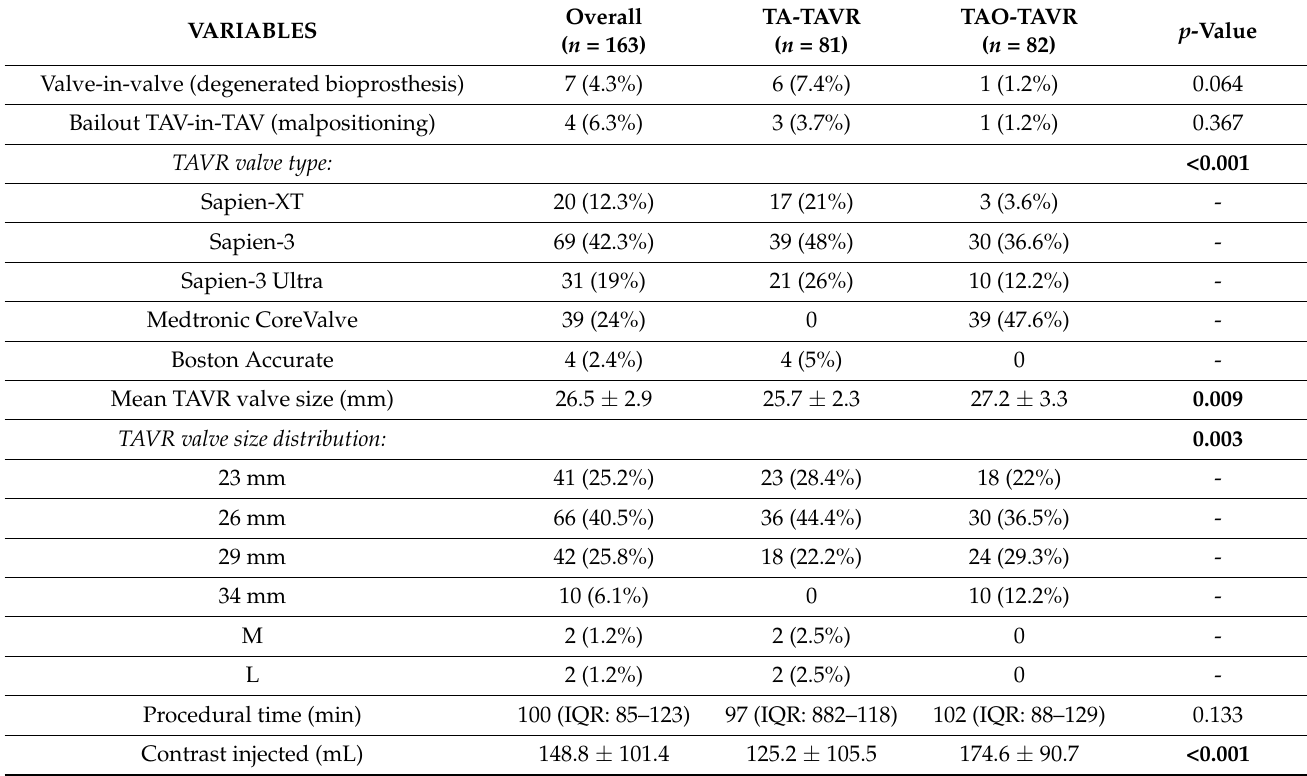
Table 3. Procedural